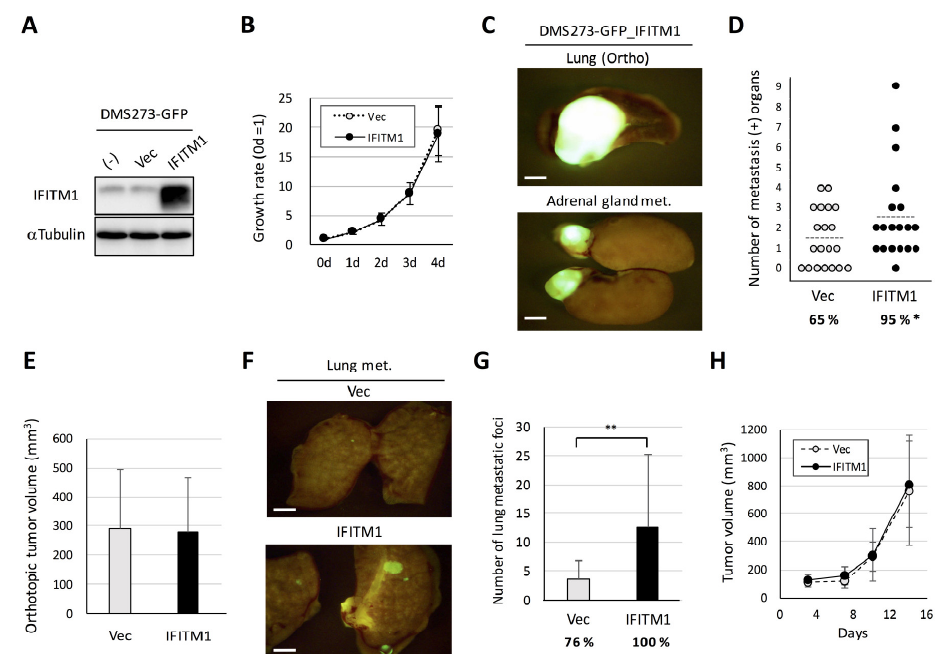
Figure 4. Effect of IFITM1 overexpression on the metastatic formation of DMS273-GFP cells in nude mice. ( A ) Western blotting for IFITM1 in IFITM1-overexpressing DMS273-GFP cells. Whole-cell lysates (20 µg) were separated by 15% SDS-PAGE, and membranes were blotted with anti-IFITM1 (top panel) and anti-α-tubulin antibodies (bottom panel, loading control). ( B ) In vitro growth rate of IFITM1-overexpressing cells as determined using the 3-(4,5-dimethylthiazol-2-yl)- 2,5 diphenyltetrazolium bromide (MTT) assay. The growth rate was calculated as the ratio of the absorbance of cultured cells to that of cells on day 0. Data are expressed as the mean ± SD of three independent experiments performed in triplicate. ( C – E ) Orthotopic tumor growth and metastatic formation in the orthotopic model using DMS273-GFP vector control cells (n = 19) or IFITM1-overexpressing cells (n = 20). In total, 2.5 × 10 5 cells were transplanted into the left lung of each nude mouse. One hundred micrograms of anti-asialo GM 1 were injected into mice intravenously before and after tumor inoculation (a total of four injections). Mice were sacrificed when they became moribund, and orthotopic and metastatic tumors were assessed. ( C ) Representative fluorescence images of the orthotopic tumors and adrenal gland metastases of mice transplanted with IFITM1-overexpressing cells. Bar, 2 mm. ( D ) Distant metastatic tumor formation. The dotted lines represent the means of the number of metastasis-positive organs per mouse. Percentages show the incidence of distant metastasis. * p < 0.05, Fisher’s exact test. ( E ) Orthotopic tumor formation. Results are expressed as the mean + SD. ( F , G ) Metastatic colony formation in lungs in experimental metastasis models generated using DMS273-GFP vector control (n = 17) or IFITM1-overexpressing cells (n = 14). In total, 1 × 10 6 cells were injected into the tail vein of each nude mouse. At 7 weeks post-inoculation, lungs were dissected, and metastatic foci were counted. ( F ) Representative fluorescence images of the lung metastases of both groups. Bar, 2 mm. ( G ) Percentages show the incidence of distant metastasis. ** p < 0.01, Mann–Whitney U-test. ( H ) Subcutaneous tumor growth of DMS273-GFP vector control and IFITM1-overexpressing cells. Cells (1 × 10 6 ) were inoculated subcutaneously in nude mice (n = 6). The tumor volumes are shown as the mean ±